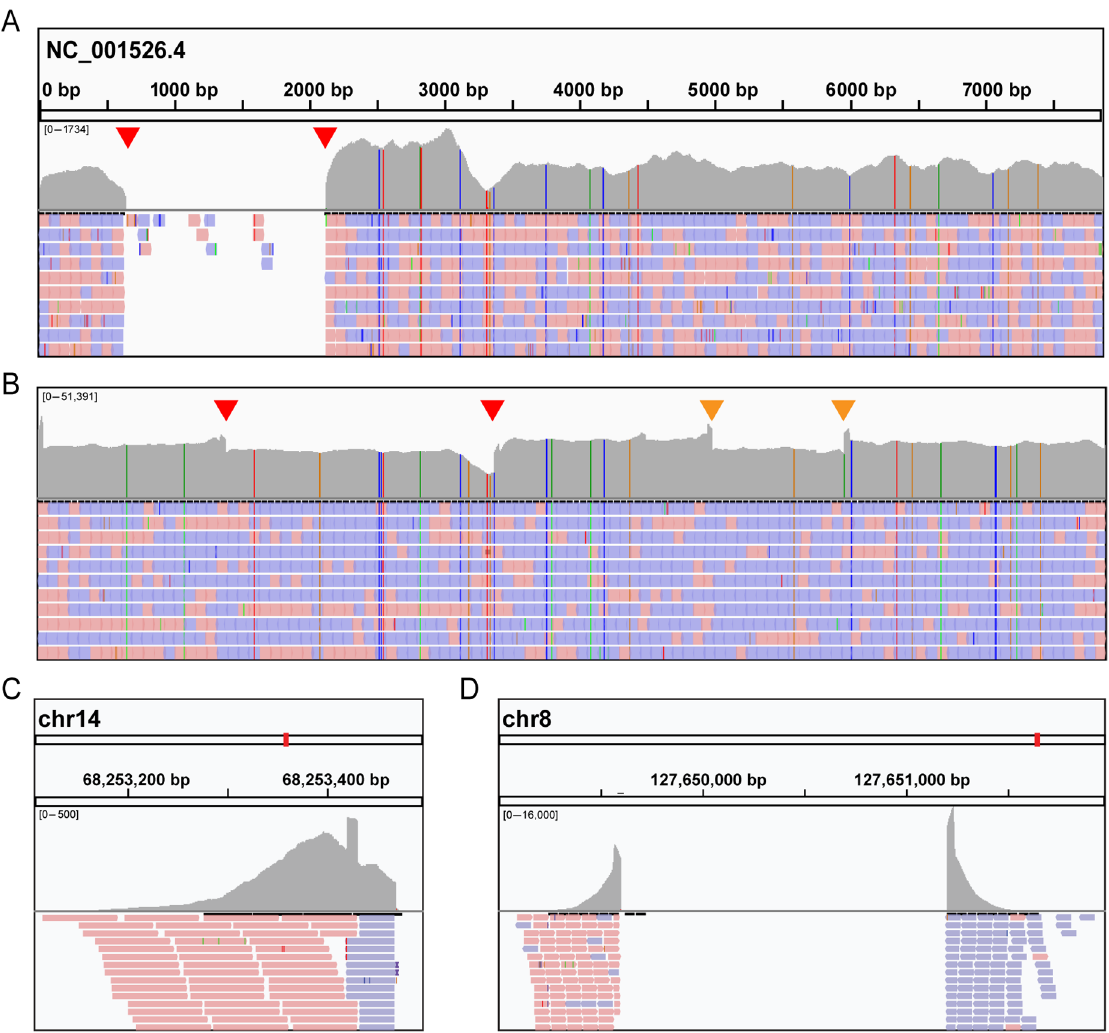
Figure 2. Characterization of human papillomavirus (HPV) integration in brain metastases by targeted sequencing. After sequencing the targeted libraries, reads were aligned to HPV16 reference genome (NC_001526.4) and visualized by IGV software. ( A , B ) Extensive coverage of the HPV genome was seen in both Case 1 ( A ) and Case 2 ( B ). Red arrows indicate discontinuities where chimeric reads between HPV and human genomes were detected. In addition, other discontinuities were detected in Case 2 (orange arrows). ( C , D ) In the lower panels, human DNA reads from chimeric HPV-human sequences are displayed, indicating an insertion site into the human genome at 14q24.1 (Case 1, ( C )) and 8q24.21 (Case 2, ( D )). Red (Forward) and blue (Reverse) colors correspond to specific strands.